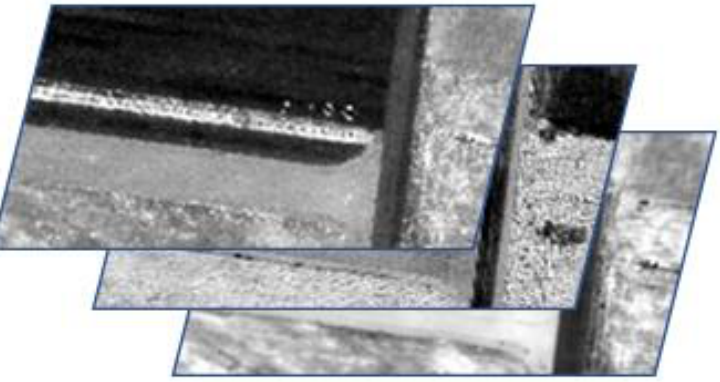
Figure 2. Superimposed images.